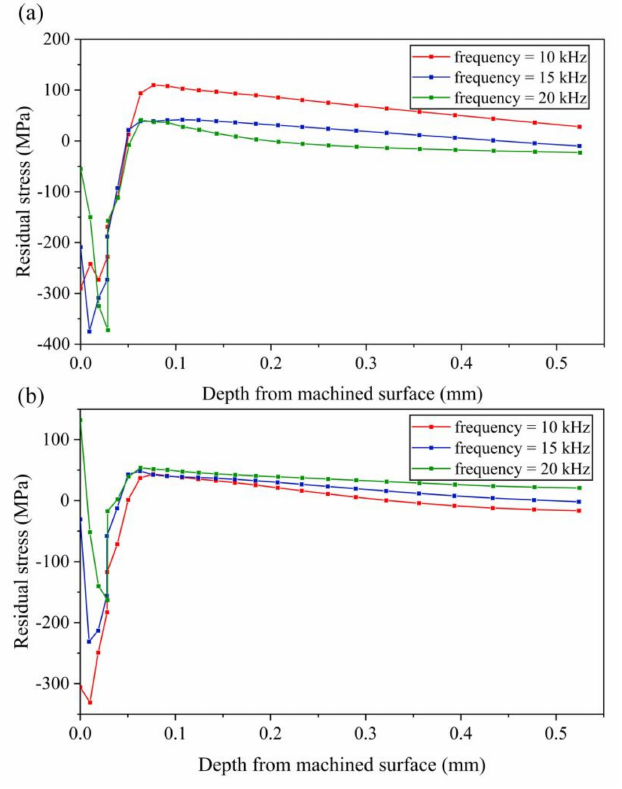
Figure 16. Results of residual stress with various vibration frequencies ( a ) stress-xx ( b )